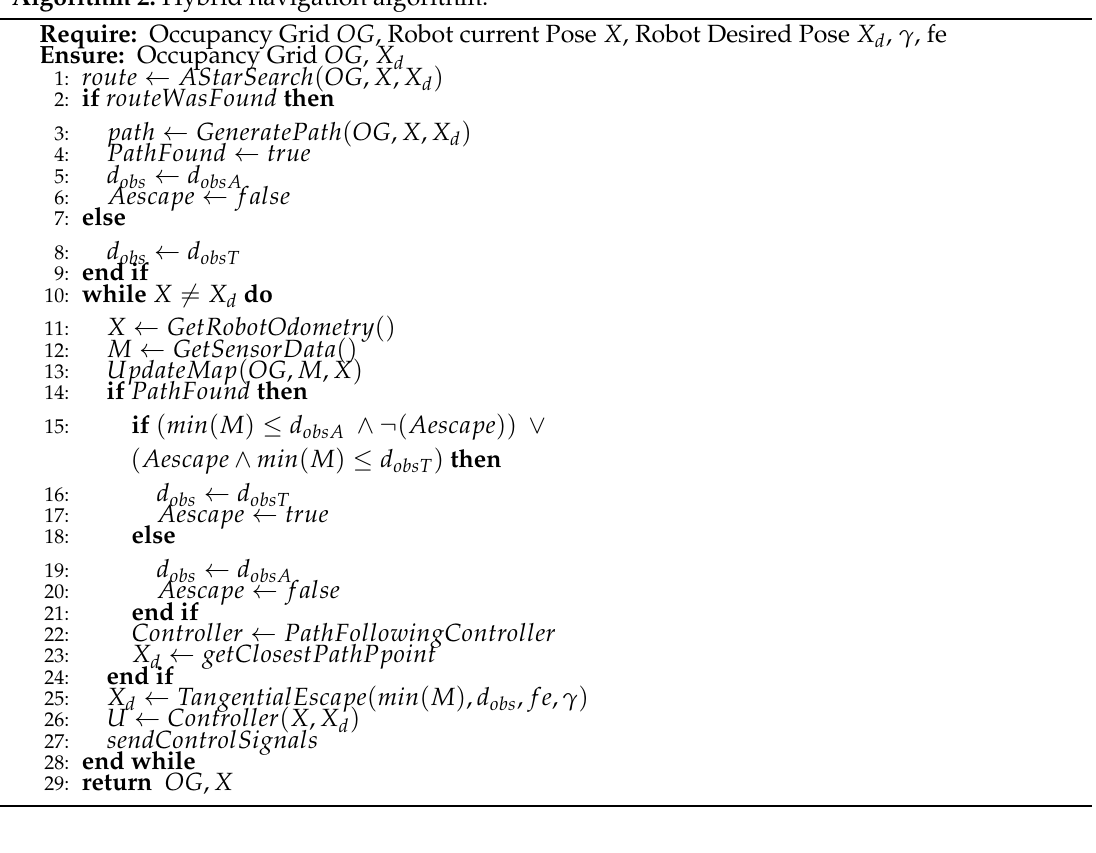
Algorithm 2: Hybrid navigation